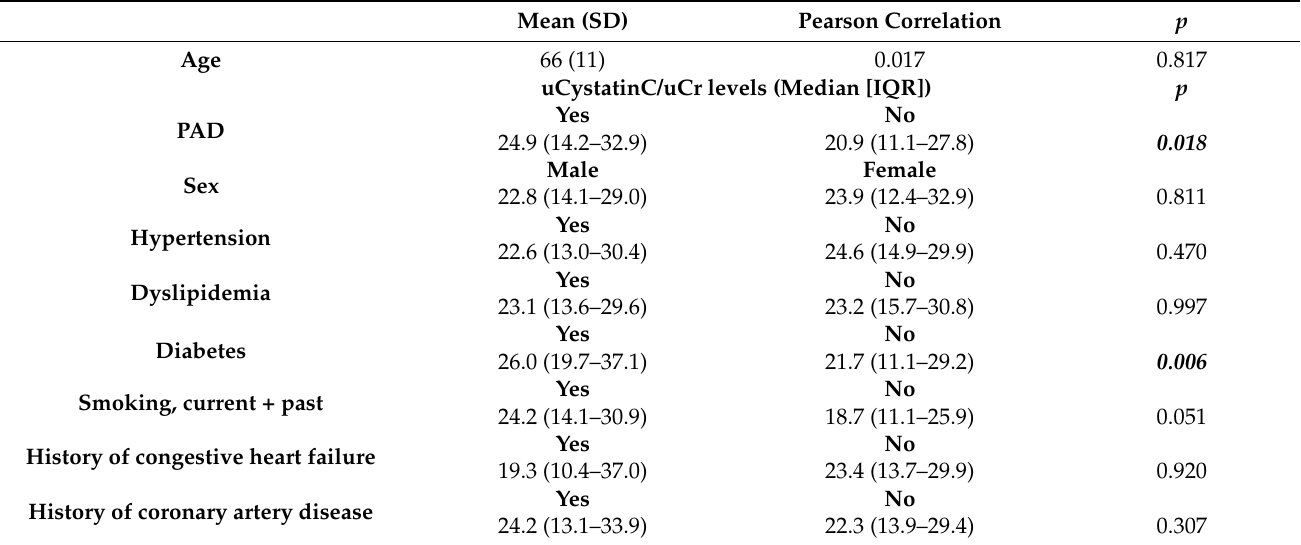
Table 2. Association between uCystatinC/uCr levels and demographic/clinical characteristics.